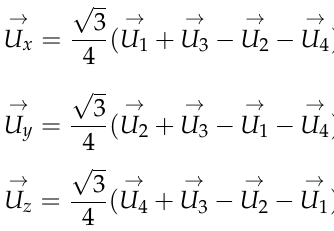
→ U ( ω ) are the Fourier transform of the sound pressure P ( t ) In the formula, P ( ω ) and → U ( t ) at the center point, respectively; Re is the real part of the and the particle velocity complex number, and Im is the imaginary part. The superscript “*” indicates the conjugate of the complex number. G 12 is the cross-power spectrum on the sound pressure of the two microphones, and ∆ r is the distance between the microphones. As shown in Figure 1, the vector synthesis of the four particle velocities from the four microphones to the center O corresponds to the total particle vibration velocity at the center O. By decomposing the particle vibration velocity into 3 coordinate axes, we can